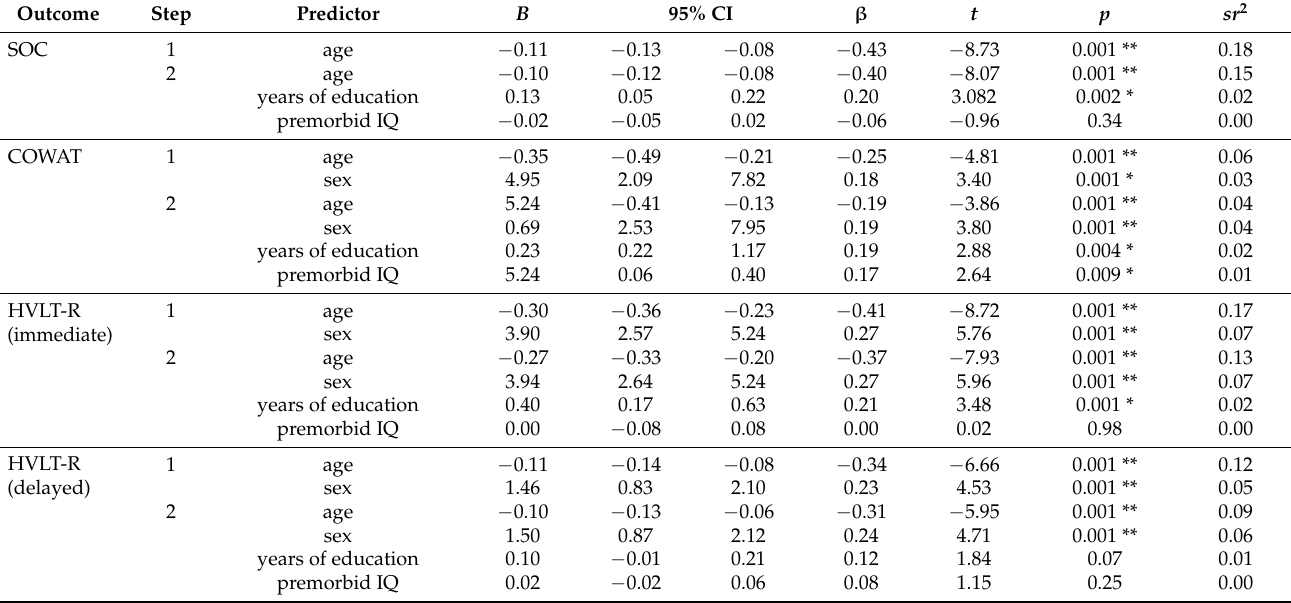
Table 3. Unstandardized (B) and standardized ( β ) regression coefficients and squared semi-partial correlations (sr2) for cognitive reserve proxies predicting